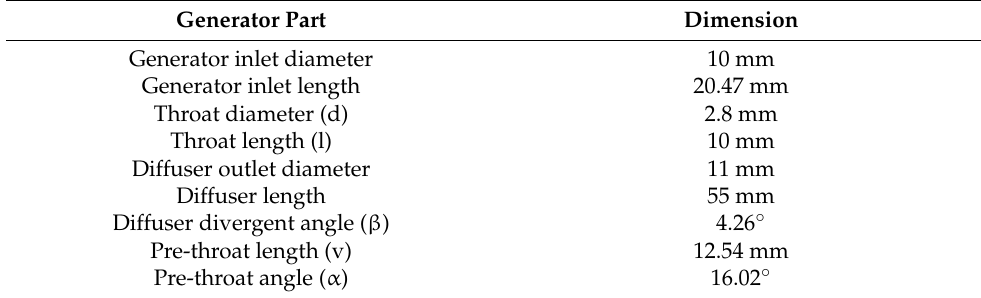
Figure 4. The microbubble Generator computational domain. Table 1. The dimensions for experimental generator (baseline case).